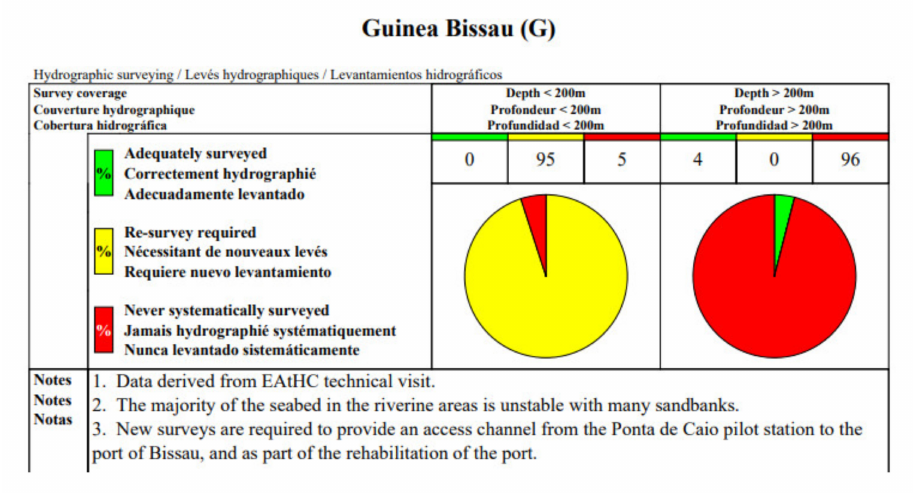
Figure 5. Guinea-Bissau status of hydrographic surveying in accordance with International Hydrographic Organization (IHO) information (adapted from IHO [55] (p